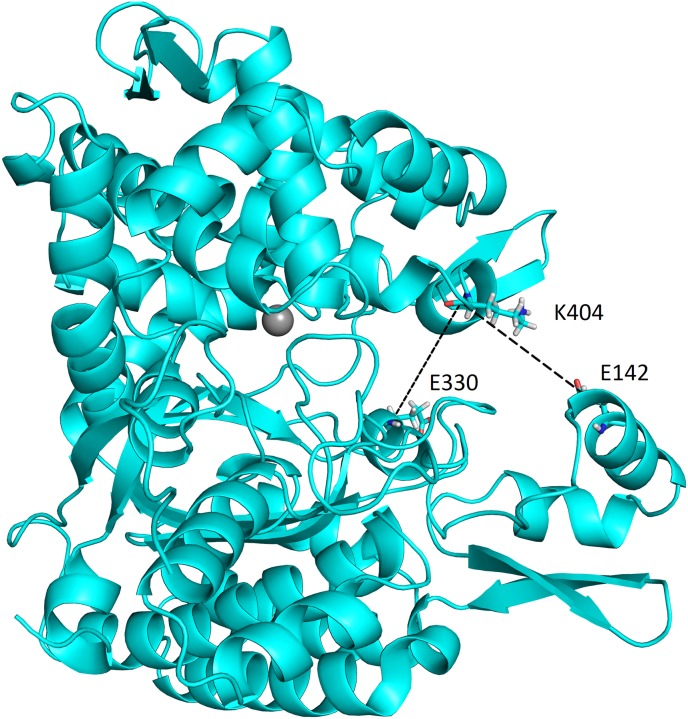
Interactions between Arg2-2NA and the amino acid residues in the binding site of the HEISGH CaDPP III mutant.The figure was prepared using the PyMol program [51].